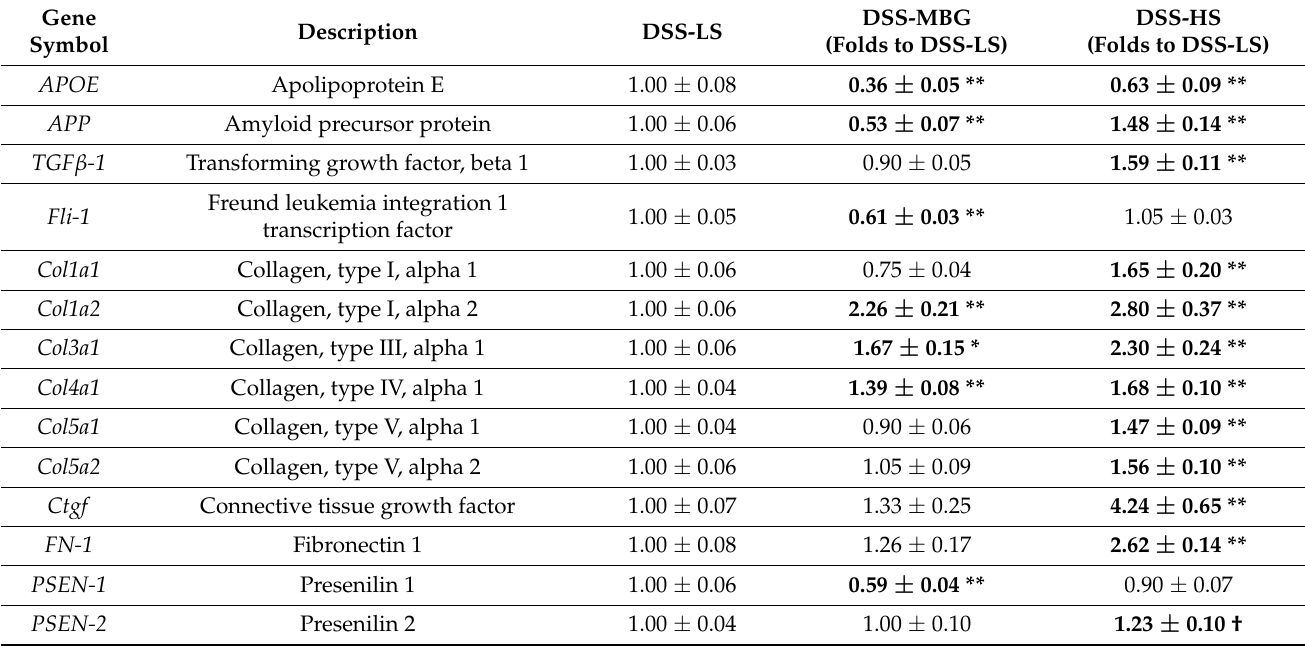
Table 5. Expression of fibrosis-associated and other genes in left ventricles from Dahl salt-sensitive ( DSS ) rats treated with MBG or HS vs. LS control by qPCR test.